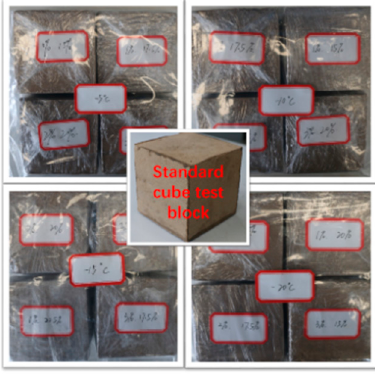
Figure 1. Standard cube test block.